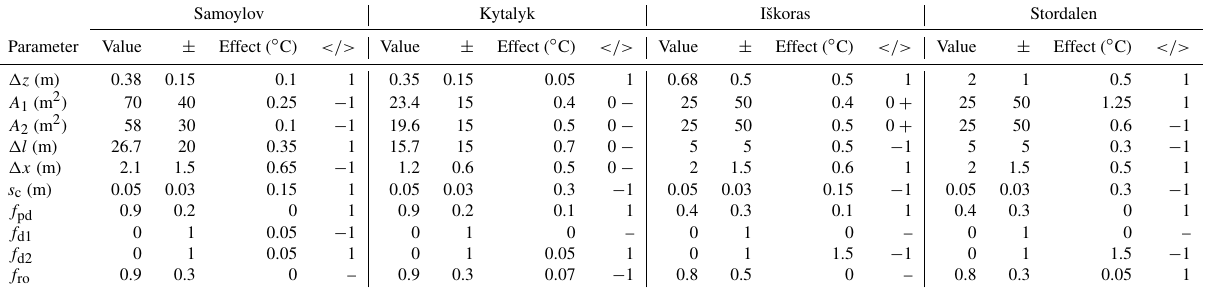
Table 5. Estimated parameter values (value) and uncertainties ( ± ) by site, and the resulting effect of the parameter uncertainty on the size of the July temperature splitting at 0.19m depth (effect). </> indicates whether increasing the parameter causes the temperature splitting to increase (1) or decrease ( − 1) or whether it indicates the presence of local maxima (0 + ) or minima (0 − ). Samoylov Kytalyk Iškoras Stordalen Parameter